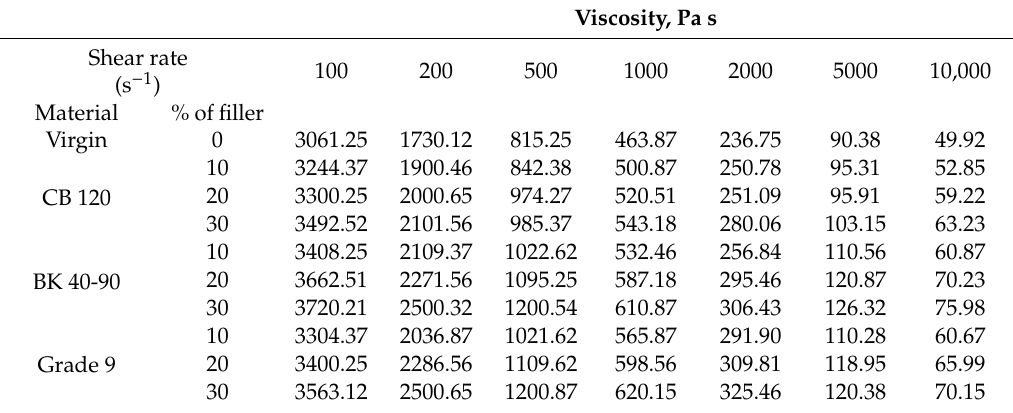
Table 3. Viscosity values for Solanyl ® composites with a varying wood flour fraction, C120, BK 40-90, and Grade